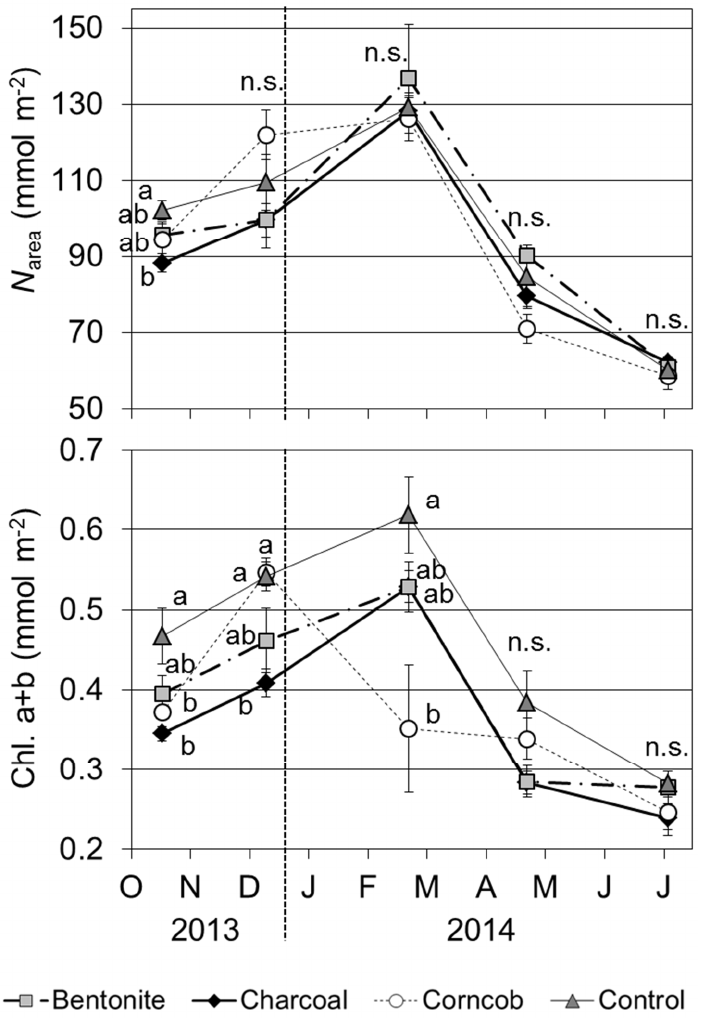
Figure 8. Concentrations of area-based nitrogen ( N area ) and total chlorophyll (a + b) for teak seedlings grown in the four treatments (9–11 a.m., Mean ± SE, n = 4).